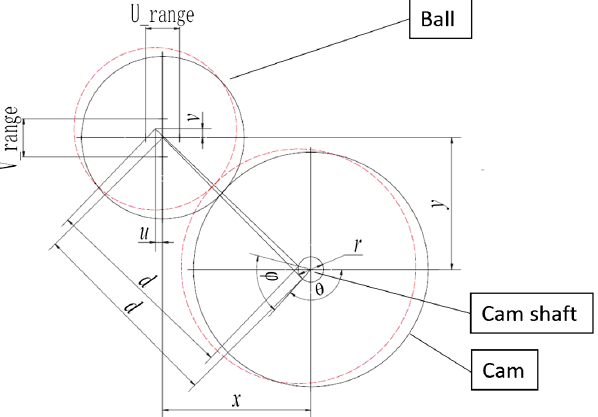
FIG. 9. The diagrammatic drawing of the one ball-cam